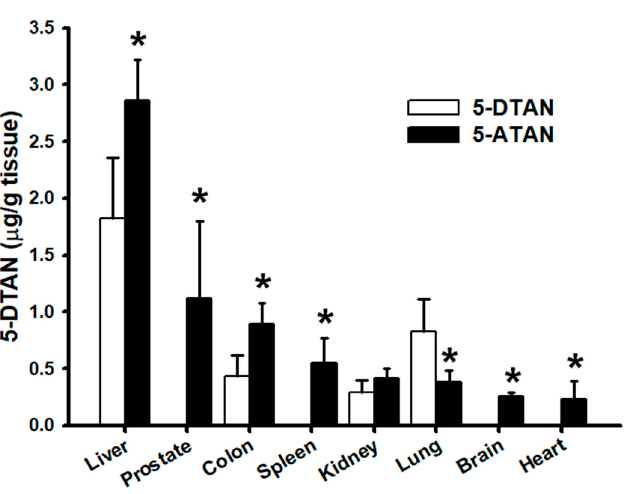
Figure 7. Tissue distribution of 5-DTAN in C57BL/6J mice following oral administration of 50 mg/kg of 5-DTAN or 5-ATAN for 7 consecutive days. Data are expressed as means ± SD ( n = 6). * p < 0.05 compared with 5-DTAN-administered group.